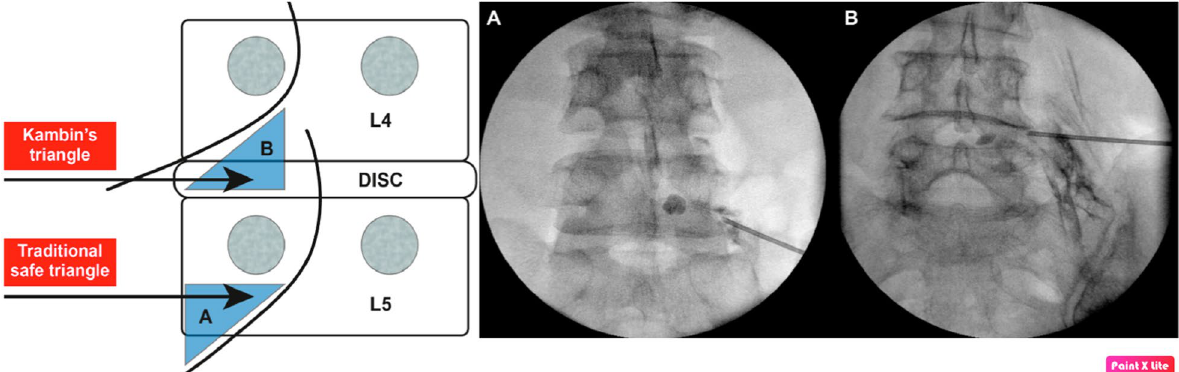
Fig. 4 Drawing on the left shows; A the traditional safe triangle for lumbar transforaminal injection, B the Kambin’s triangle for lower transforaminal injections. The fluoroscopic AP views on the right show dye injection at; A traditional sat triangle, B Kambin’s triangle. (Reproduced and edited from